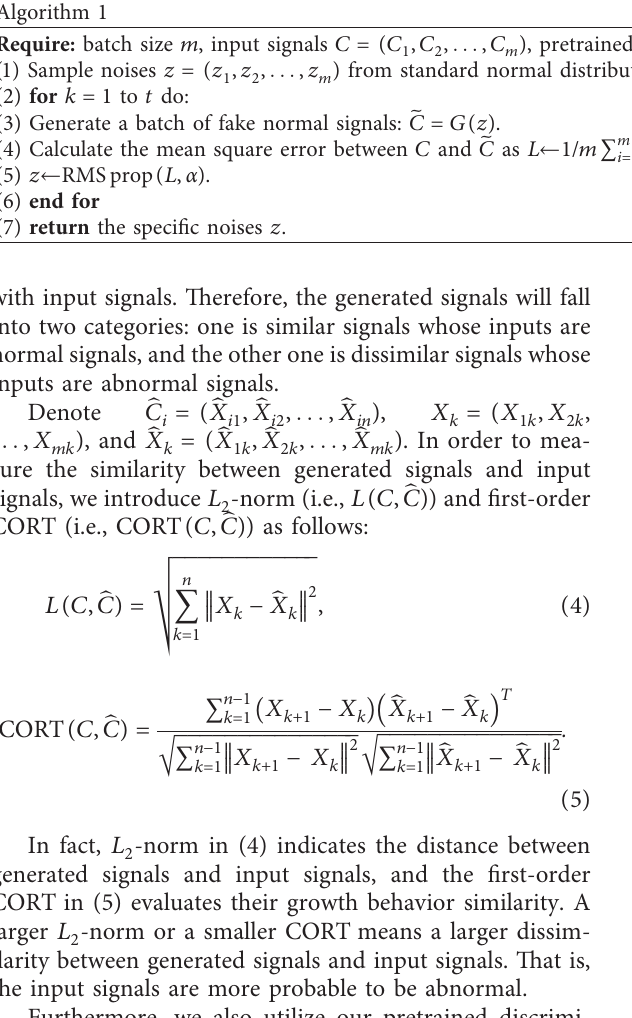
Table 1: Specific noise-searching